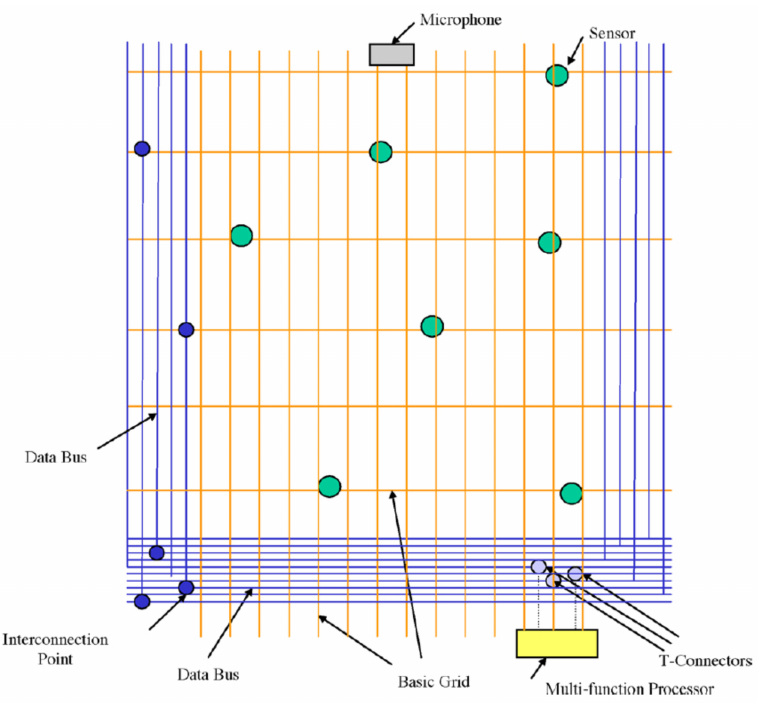
Figure 1. Architecture of the Smart Shirt/Wearable Motherboard, reprinted with permission from